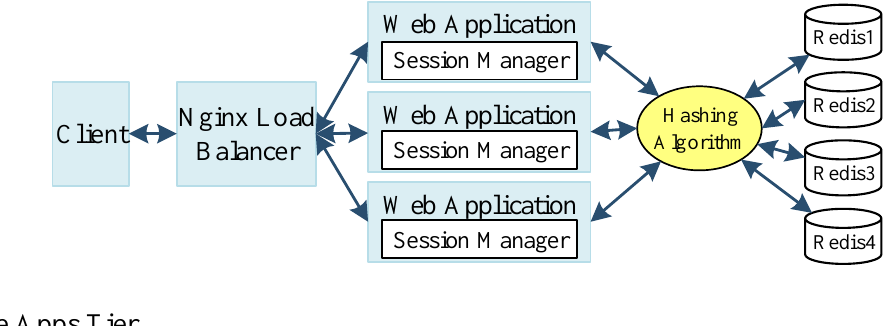
Figure 13. The load balancer, session manager and distributed redis in the OSGi web servers